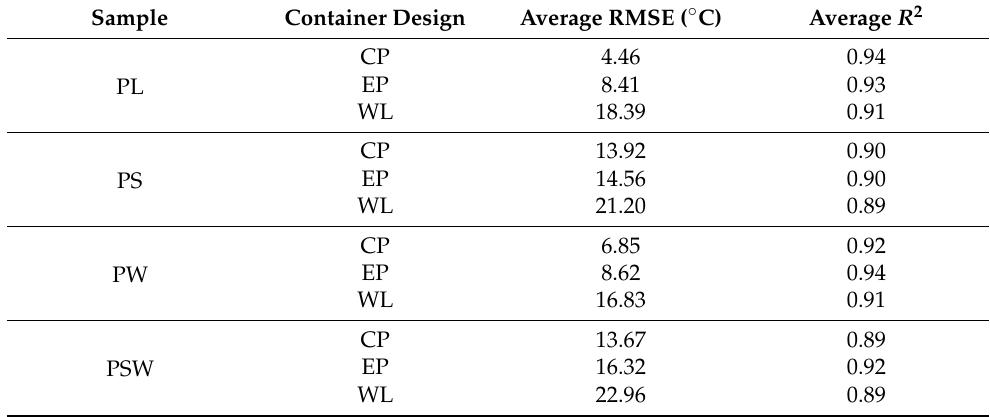
Table 3. Root mean square error (RMSE) and R 2 value of simulation and averaged experiment temperature